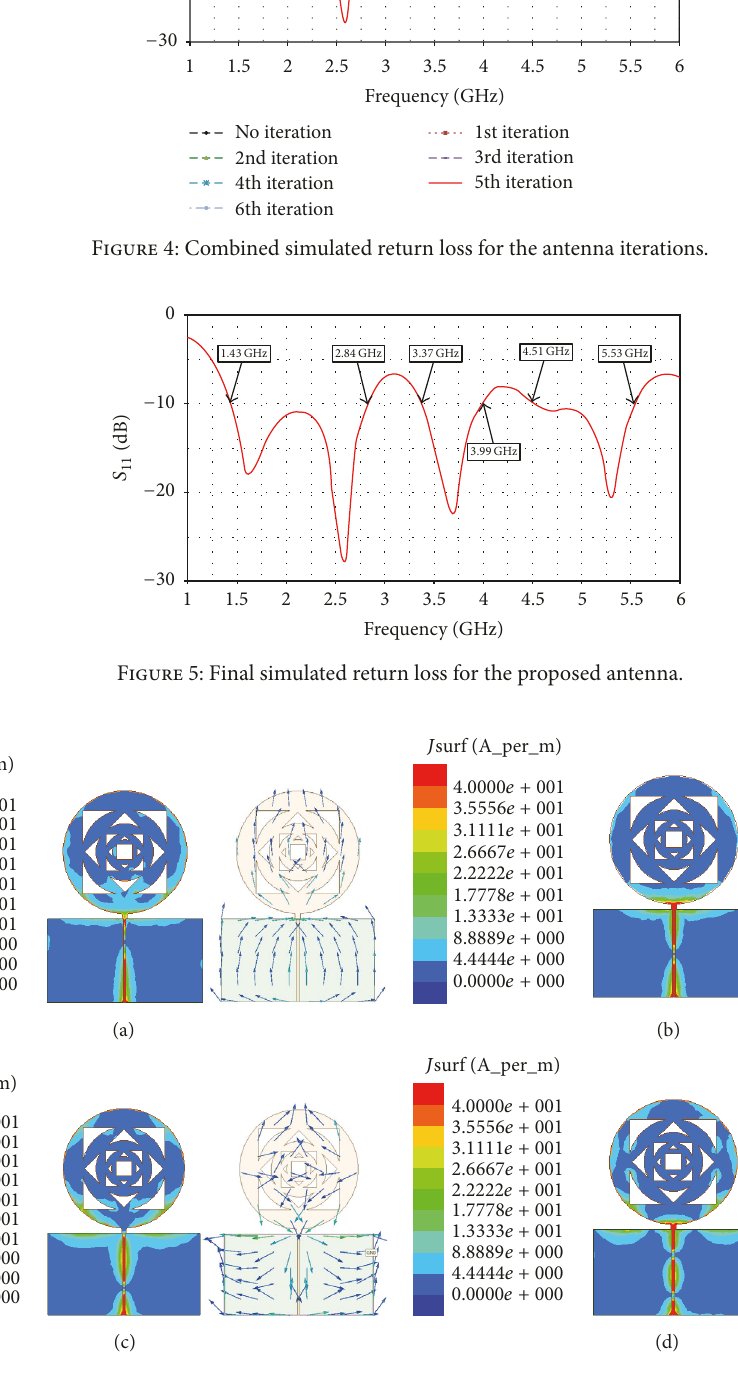
Figure 6: Current amplitude and vector distribution of the antenna at (a) 1.6GHz, (b) 2.6 GHz, (c) 3.7 GHz, and (d) 5.3